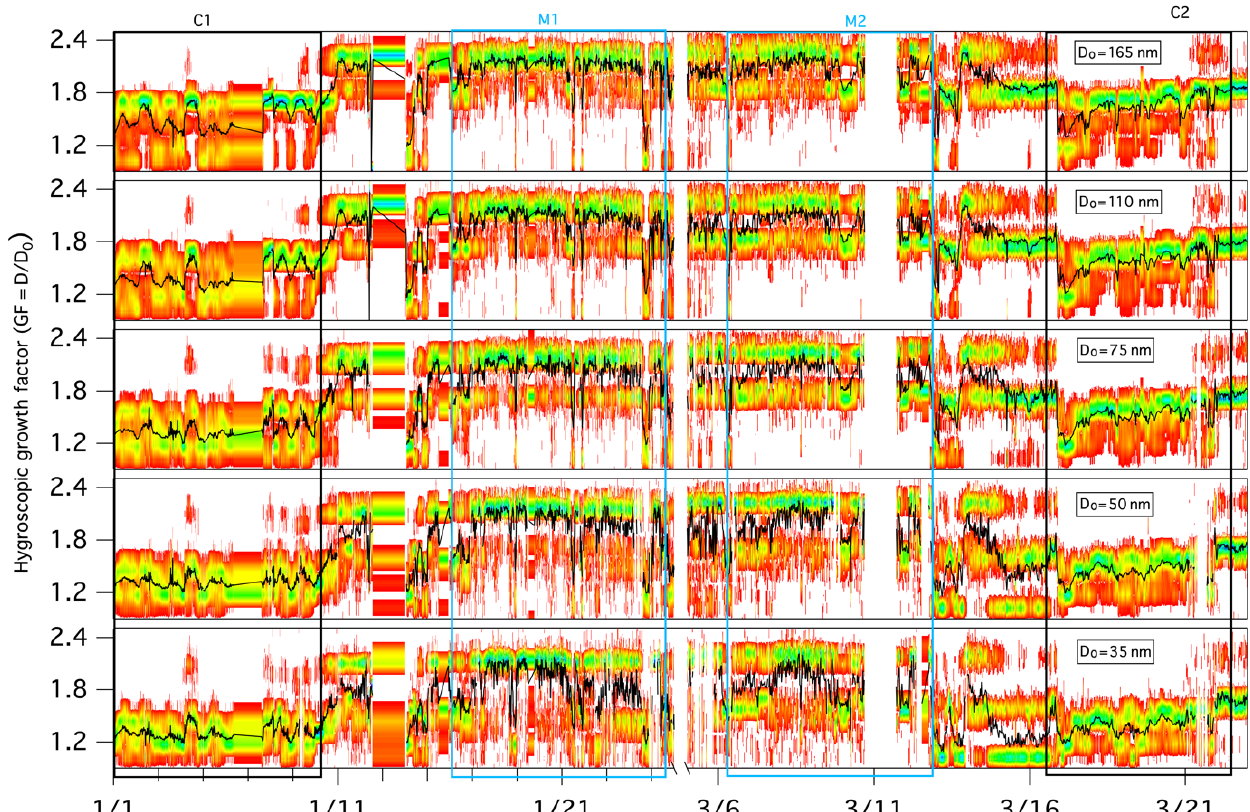
Figure 3. Growth factor probability distribution functions (GF-PDFs) for different dry particle sizes as measured by the HTDMA. The colour bar indicates the probability density, and the black line represents the averaged